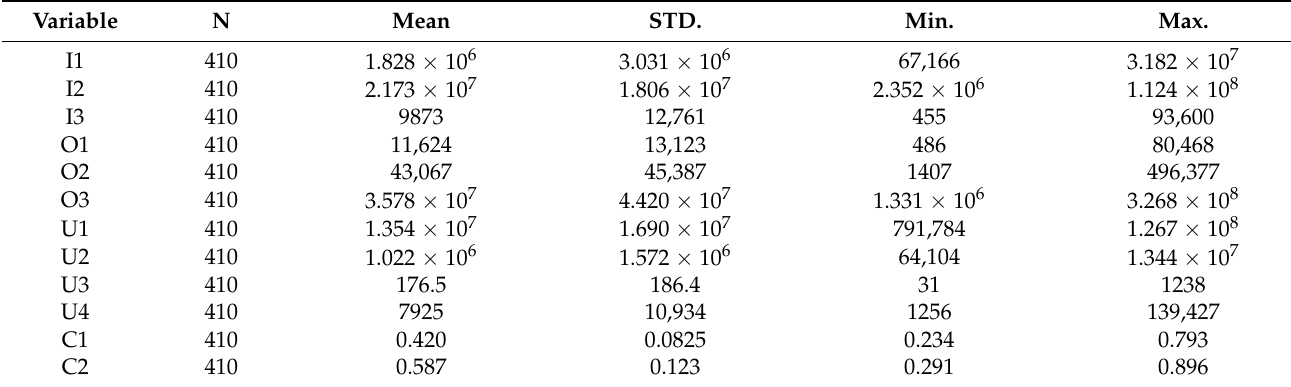
Table 2. Descriptive statistics of the